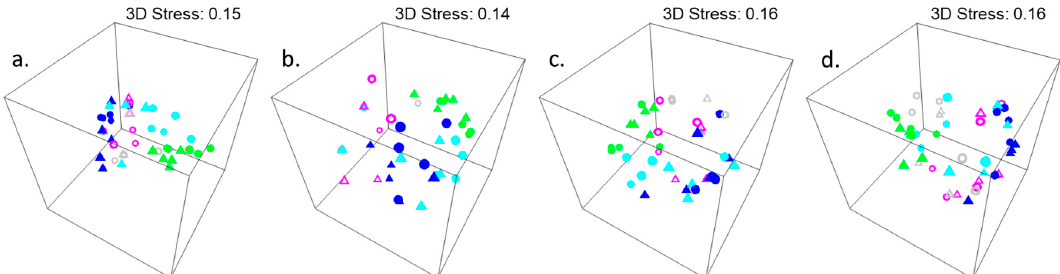
Figure A3. Non-metric multidimensional scaling (nMDS) plots of mobile invertebrate assemblages associated with different levels (full cover = dark blue, patchy cover = aqua, negligible cover = green, thinned = pink, removed = grey) of Hormosira cover ( a ) 1 day, ( b ) 5 days, ( c ) 15/19 days and ( d ) 371/379 days following manipulation at each of two sites (13th Beach = triangles, Bridgewater Bay = circles). All data were fourth-root transformed. 3D nMDS plots based on Bray-Curtis dissimilarities are shown where stress exceeded 0.20 for 2D plots.